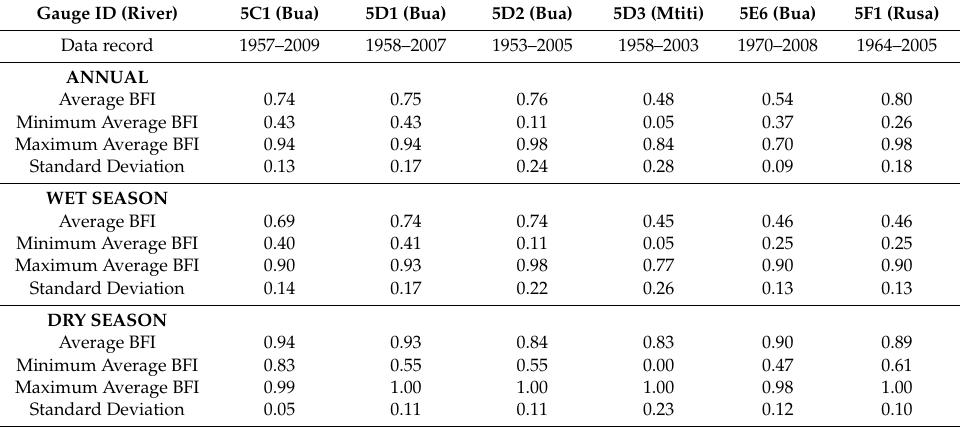
Table 4. Results of annual and seasonal BFI analysis for the gauges in WRA 5